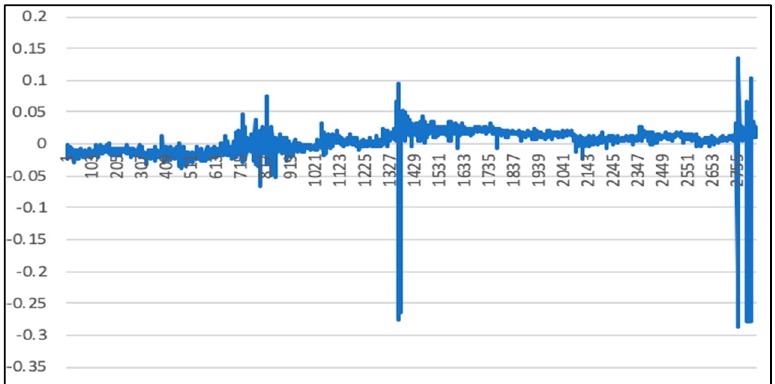
Figure 16. Error map of LSTM prediction results and actual results (first 2850 data).